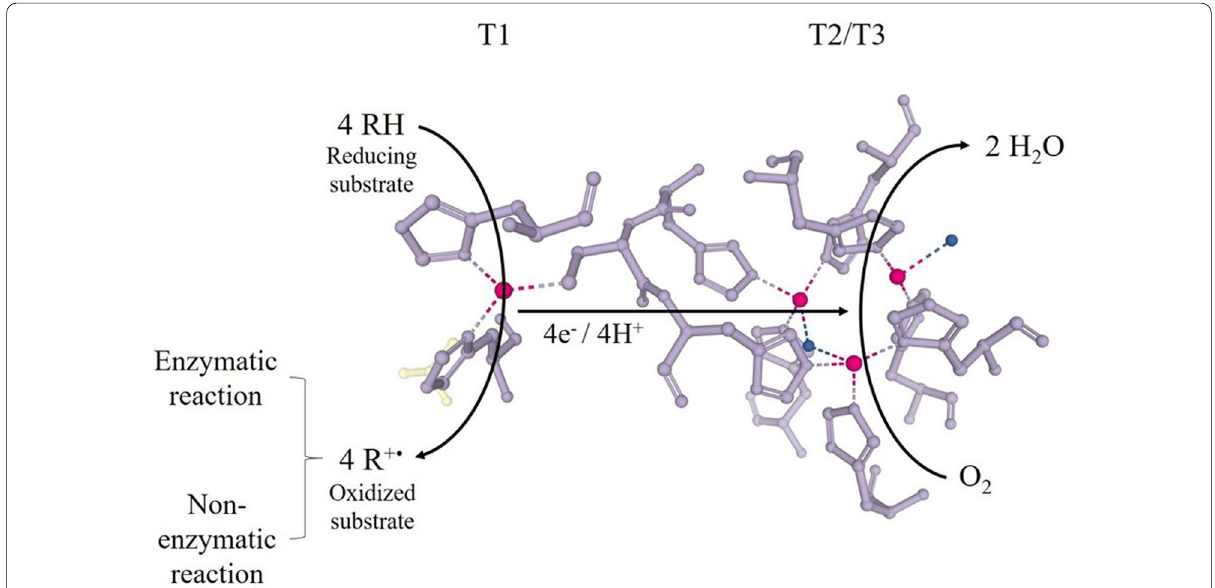
Fig. 2 Representation of laccase mechanism of action in the catalytic center of Trametes versicolor (RCBS—Protein Data Bank code PDB